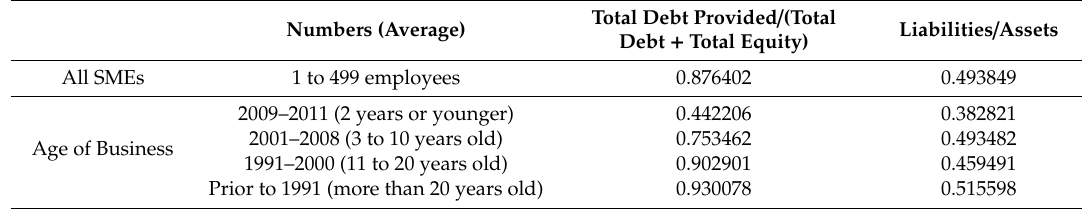
Table 8. Debt and firm